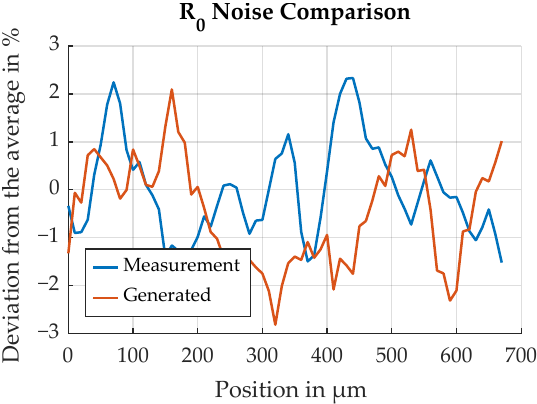
Figure 20. Qualitative comparison of the measured deviation of reflectivity R 0 and a generated random signal with the same standard deviation and similar